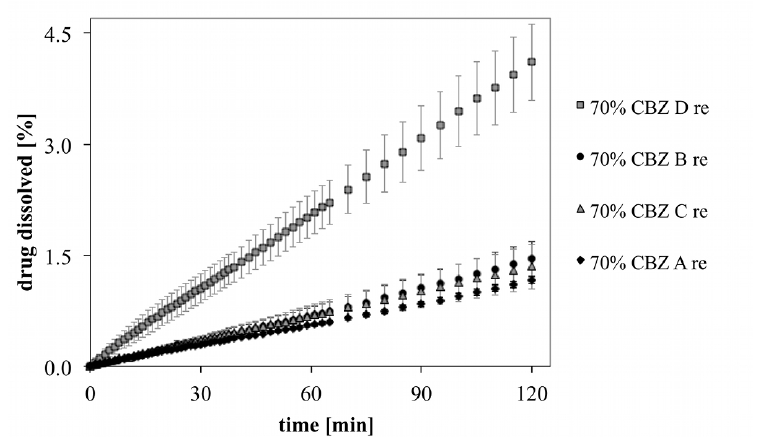
Figure 9. Initial drug release of recrystallized CBZ in binary mixtures with